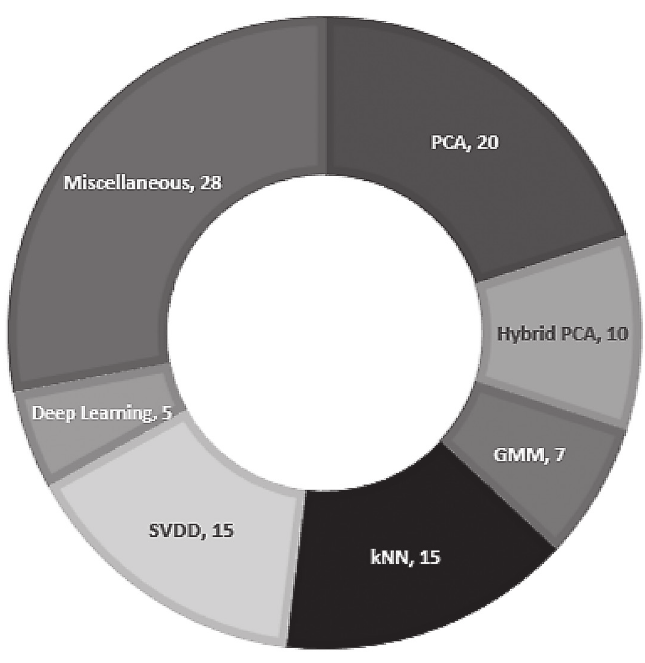
Fig. 3 – Percentage distribution of techniques analyzed